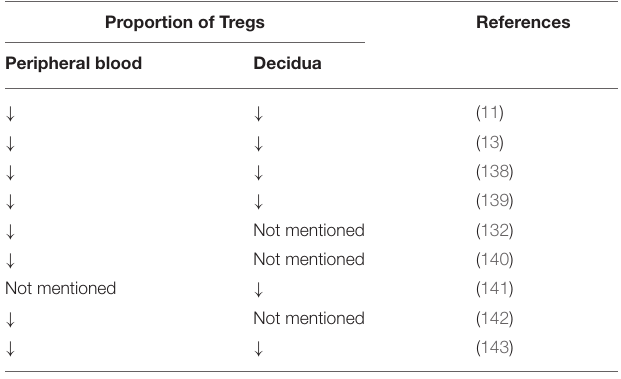
TABLE 1 | The change of the proportion of Tregs in patients with recurrent spontaneous abortion compared with normal pregnant women. Proportion of Tregs